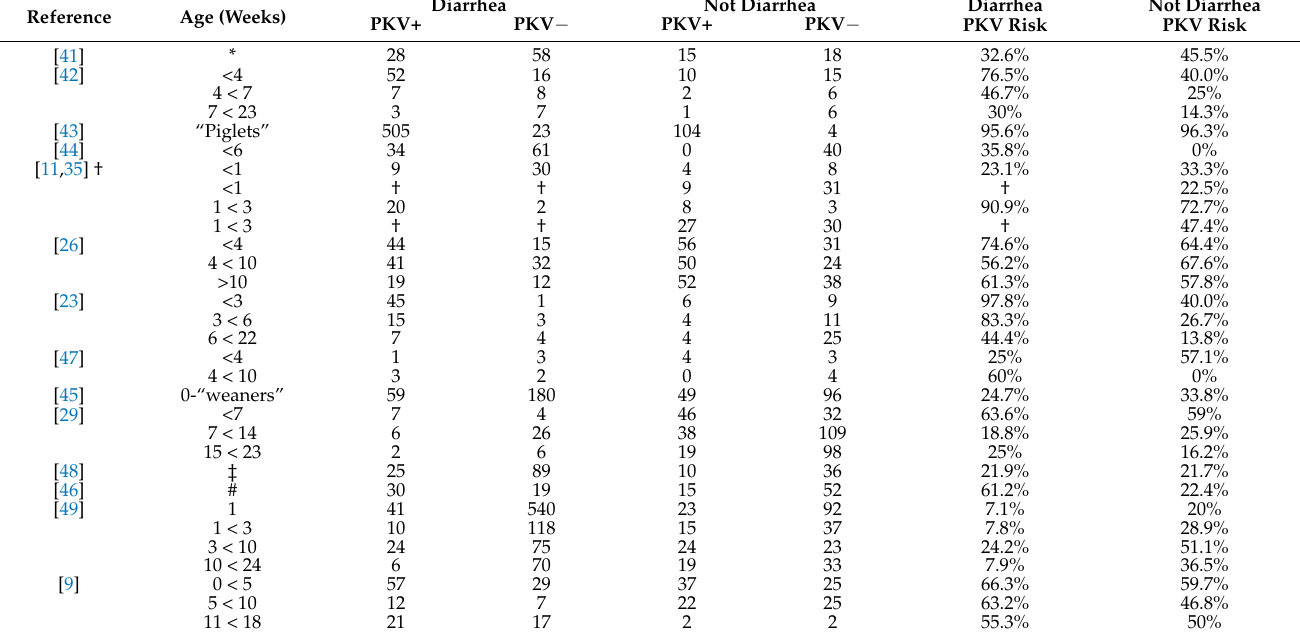
Table 3. Occurrence ( n and %) of porcine kobuvirus (PKV) in diarrheic and non-diarrheic pigs in poorly defined observational